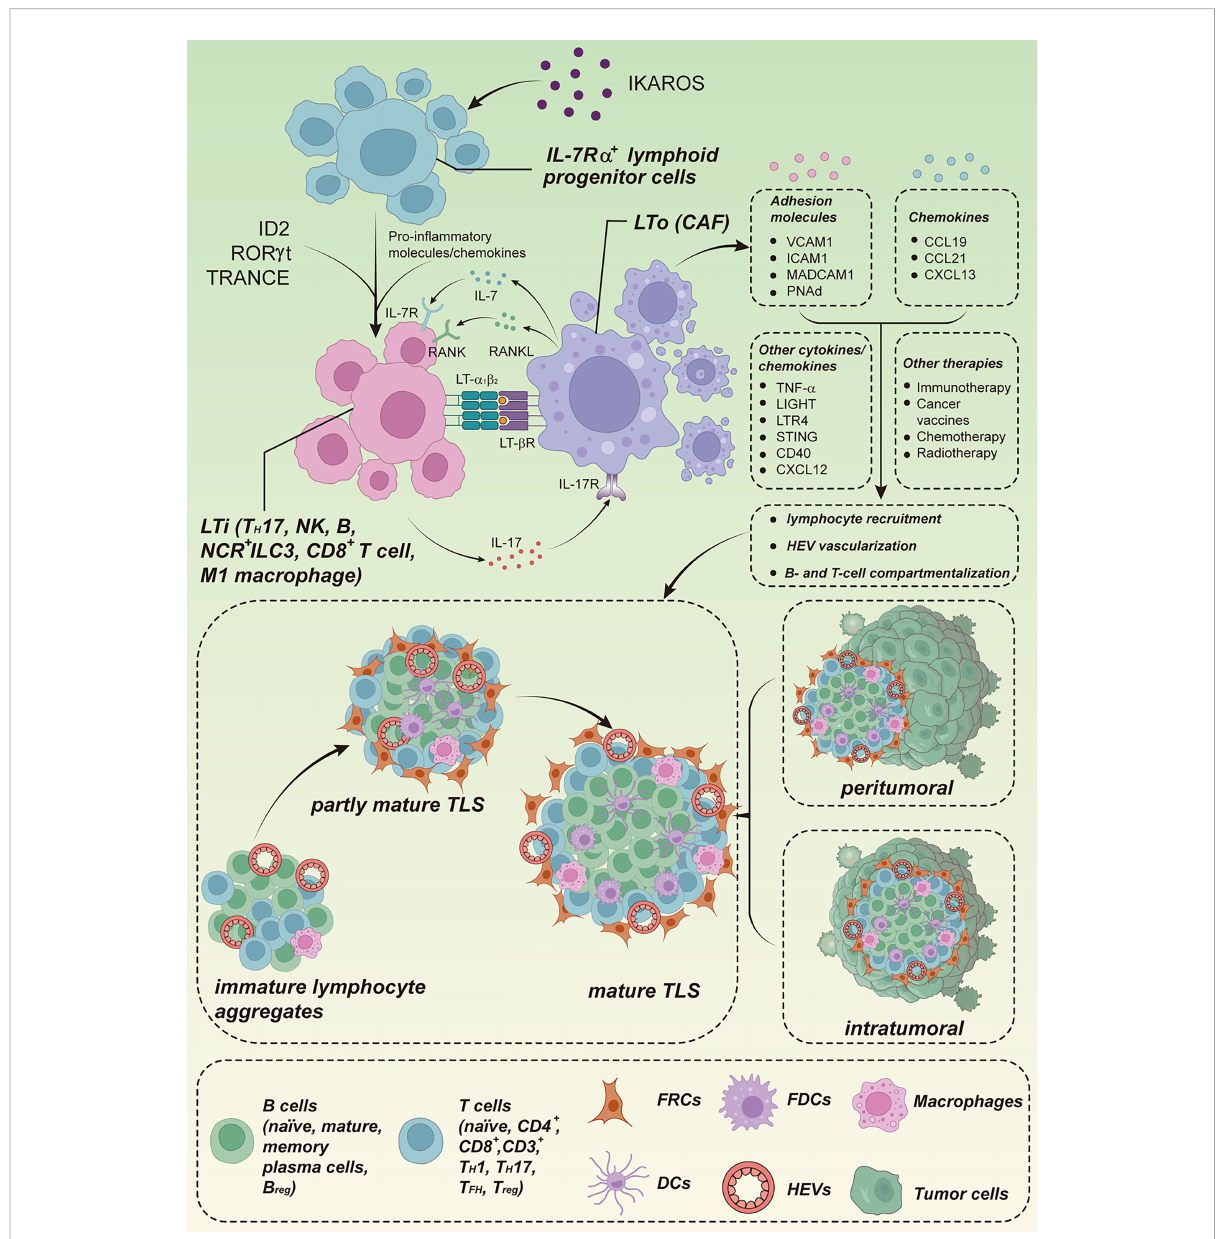
FIGURE 1 Model of TLS formation. The formation of TLSs shares similarities with the formation of SLOs. The transcription factor IKAROS regulates the production of IL-7R a + lymphoid progenitor cells, which regulate the differentiation of LTi cells using ID2, ROR g t, and TRANCE. Local accumulation of pro-in fl ammatory molecules and chemokines promotes the recruitment of LTi cells to sites of in fl ammation, and aggregated LTi and LTo cells act through a combination of signaling pathways such as LT a 1 b 2/LT b R, IL-7/IL-7R, RANK/RANKL, and IL-17/IL-17R, leading to the secretion of adhesion molecules and chemokines, which in turn promote lymphocyte recruitment, vascularization of HEVs, and B- and T- cell compartmentalisation. Some locally aggregated immune cell populations, such as T H 17 cells, NCR + ILC3 cells, M1-polarized macrophages, effector CD8 + T cells, NK cells, and B lymphocytes, have the potential to functionally replace LTi cells. Some local stromal and immune subsets also have the potential to replace LTo cells, such as CAFs. In addition, other cytokines/chemokines (TNF- a , LIGHT, TLR4, STING, CD40, CXCL12) and therapeutic regimens (immunotherapy, cancer vaccines, chemotherapy, radiotherapy) can also induce TLS. TLSs can be located intratumorally and/or peritumorally, and the maturity of TLSs progress through immature lymphocyte aggregates to partially mature TLSs with FDCs, but no GC, and fi nally to mature structures with a GC. IL-7R a , interleukin-7 receptor alpha chain; RANKL, receptor activator of nuclear factor kappa-B ligand. Cited and adapted from a published fi gure from the article “ T. N Schumacher, D. S. Thommen, Tertiary lymphoid structures in cancer. Science (2022). ” , Copyright © 2022, The American Association for the Advancement of